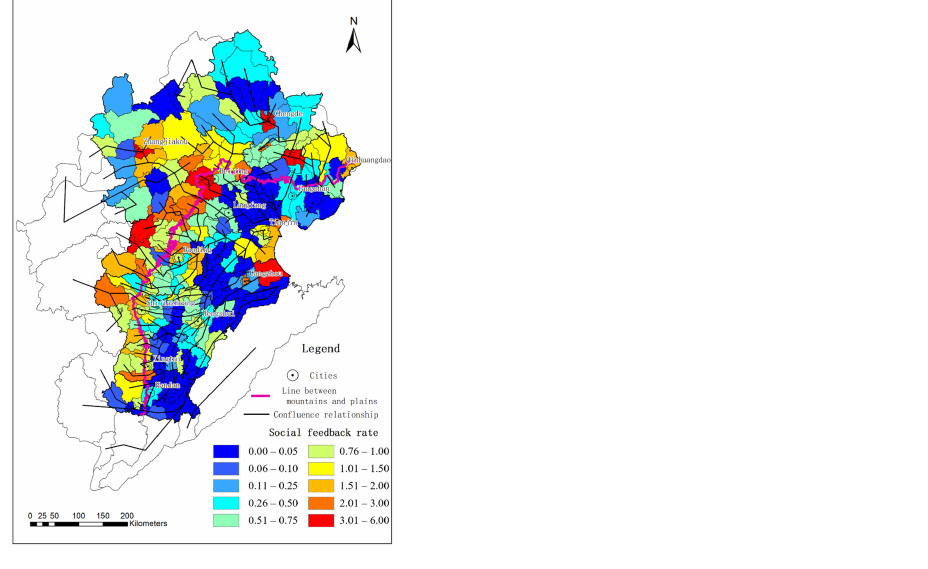
Figure 10. Social water cycle feedback rate of each unit in the Beijing–Tianjin–Hebei region under the 2035 scenario. 5.4. Mutual Feedback Relationship among Units Based on local surface runoff in the Beijing–Tianjin–Hebei region, the runoff of each socio ‐ hydrological unit under the natural water cycle in the whole region was obtained through the confluence relationship between the upstream and downstream units. The actual runoff of each socio ‐ hydrological unit in the whole region under the natural and social water cycle was then obtained after taking into account the water intake, consump ‐ tion, and discharge of the social water cycle and the storage and water supply of the